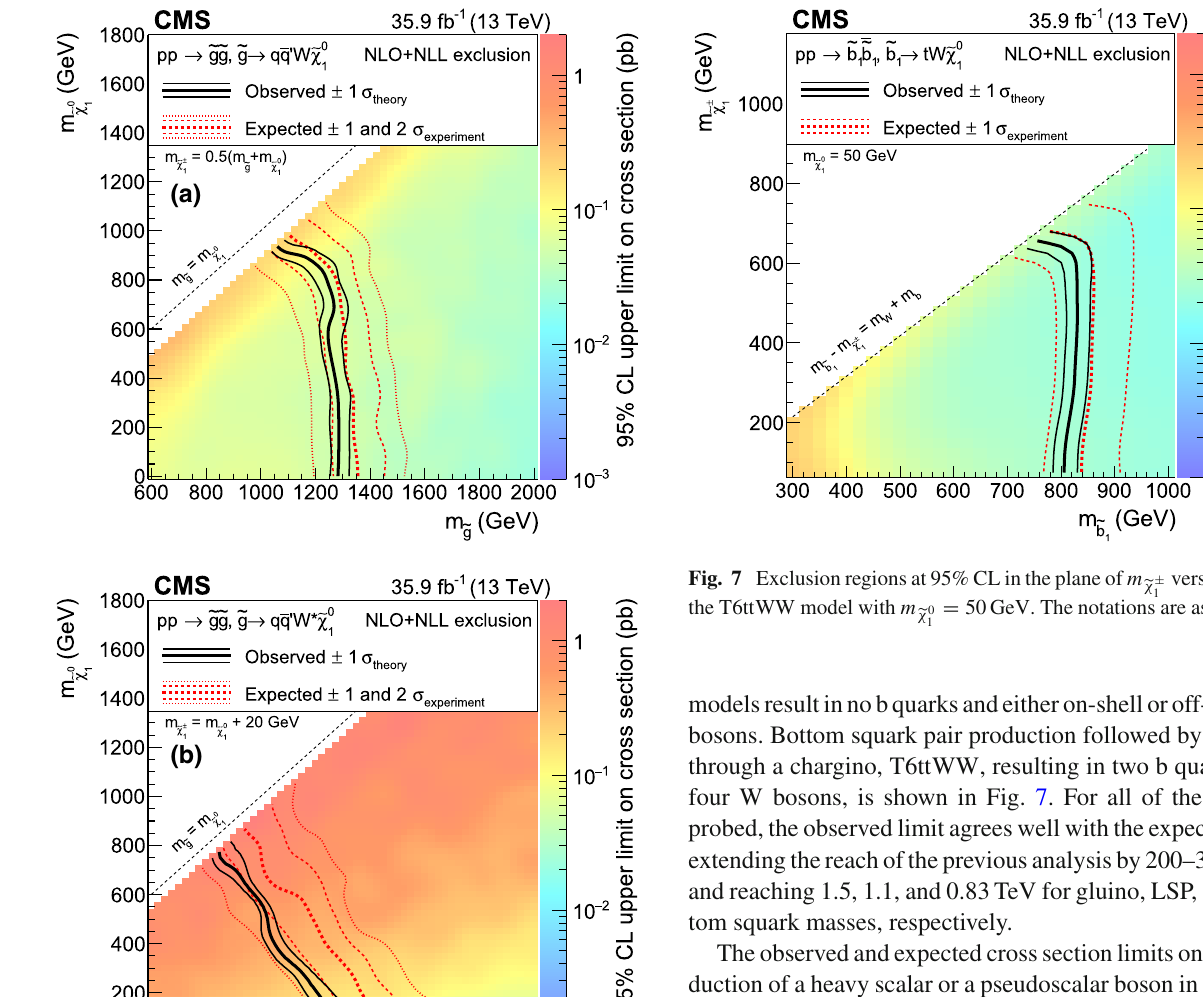
versus m (cid:2) g 1 = 0 . 5 ( m (cid:2) + m ) ( a ) and with (cid:2) χ 0 g 1 1